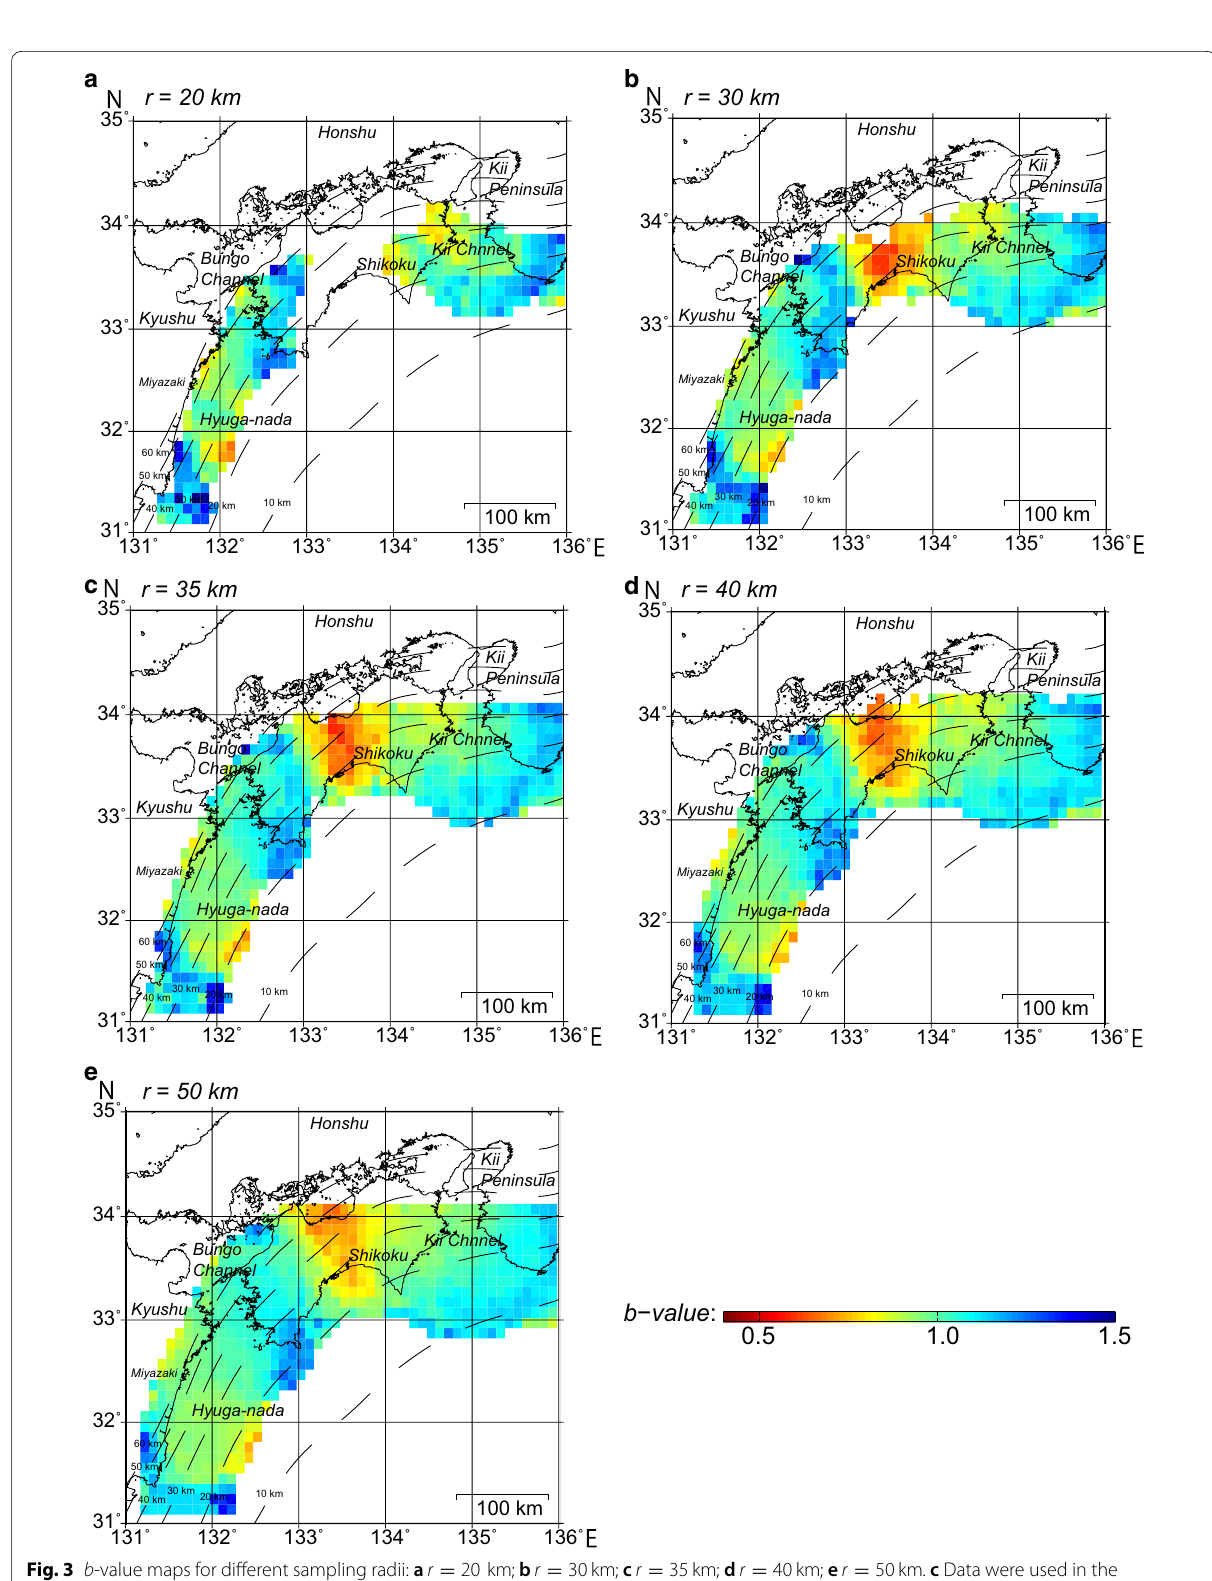
Fig. 3 b -value maps for different sampling radii: a r = 20 km ; b r = 30km ; c r = 35km ; d r = 40km ; e r = 50km . c Data were used in the subsequent analysis. If fewer than 50 events were located within the search radius of a grid node, the corresponding b -value was not